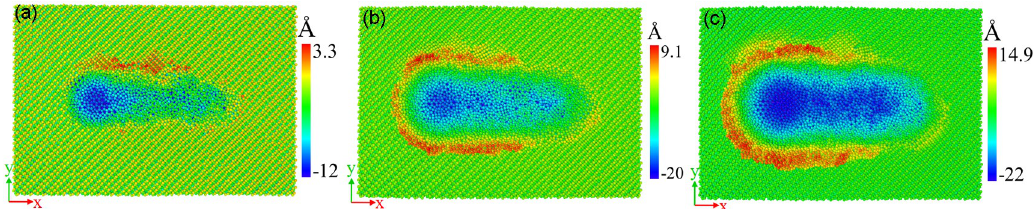
Figure 6. Top views of the GaAs(001) at a scratching distance of 10 nm for different scratching depths of ( a ) 1.0 nm, ( b ) 1.5 nm, and ( c ) 2.0 nm. Atoms are colored by heights in z direction.